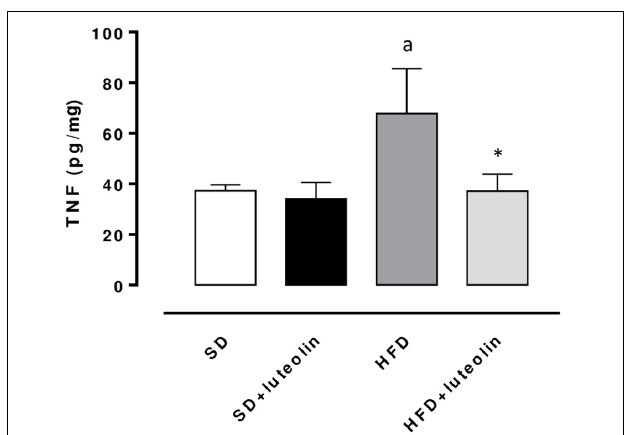
FIGURE 6 | TNF levels in mesenteric arteries obtained from mice fed with SD, SD plus treatment with luteolin (10 mg/Kg/day), HFD or HFD plus treatment with luteolin (10 mg/Kg/day) for 8 weeks. Each column represents the mean ± SEM of five animals. a P < 0.05, significant difference vs. SD; ∗ P < 0.05, significant difference vs. HFD. Statistics: two-way analysis of variance followed by Newman–Keuls